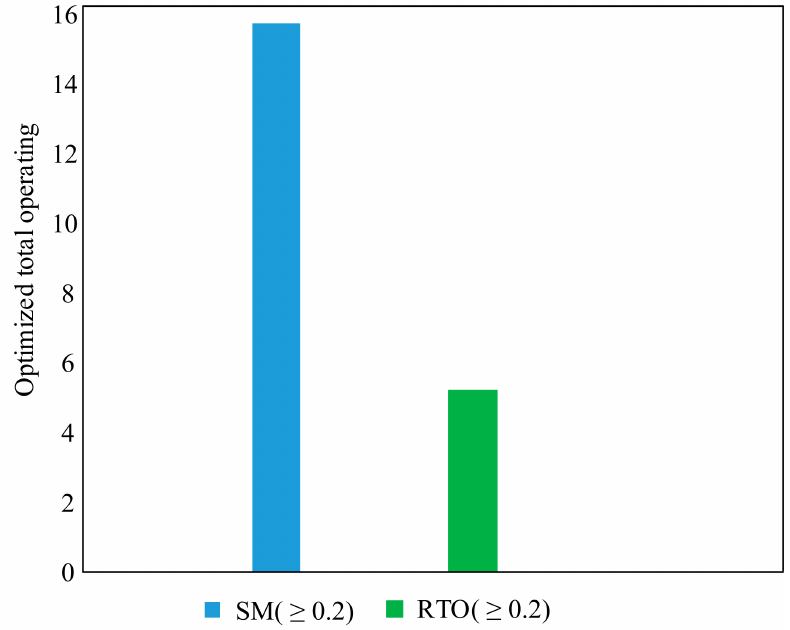
Figure 13. Optimized total operating time with the literature for Case